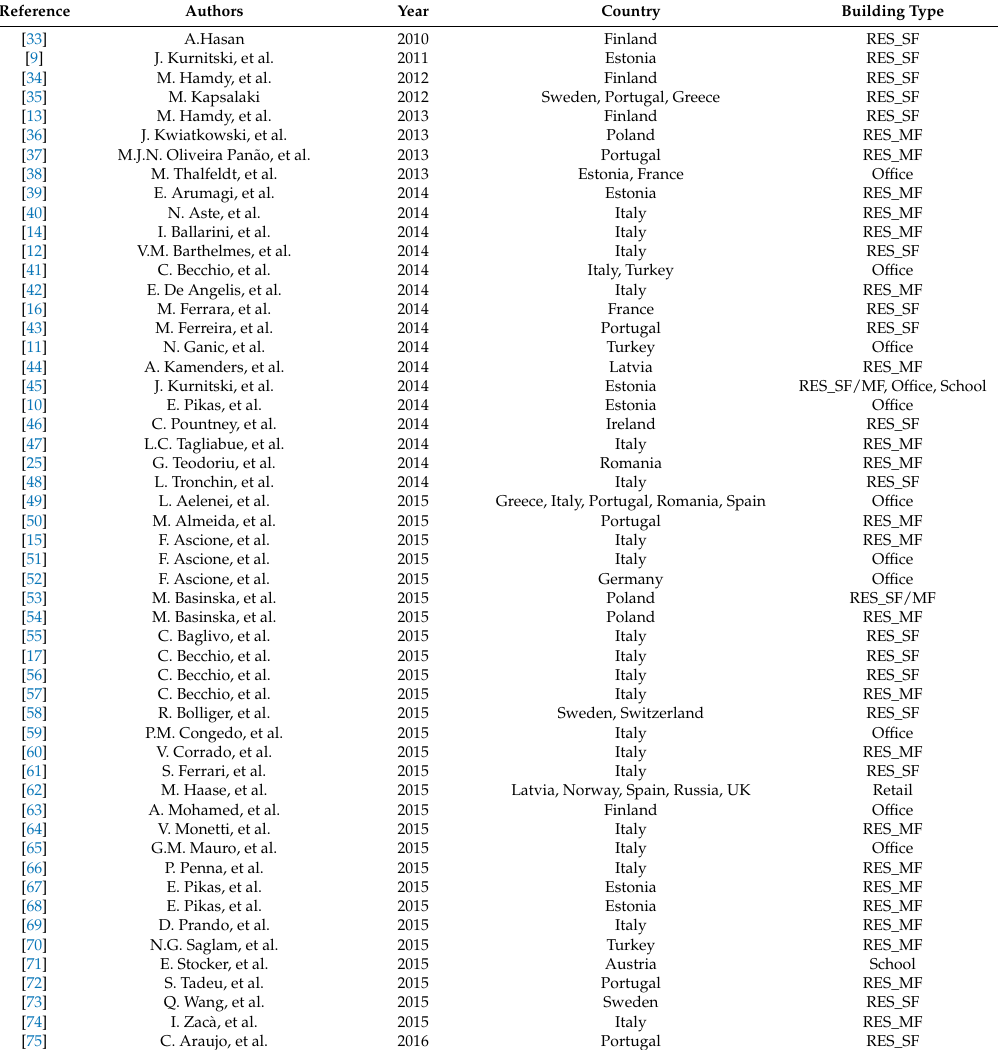
Table 2. List of papers considered in this